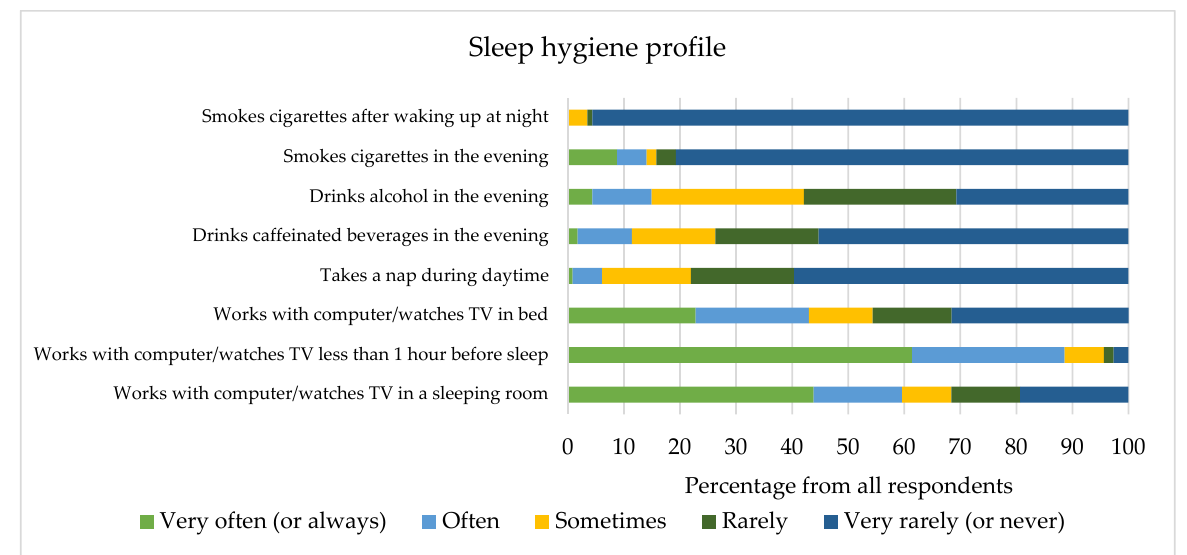
Figure 1. Questions evaluating the sleep hygiene of respondents in our study. The results of the SLOC questionnaire did not correlate significantly with aspects of respondents’ sleep hygiene habits ( p > 0.05). A lower SLOC score was associated with worse sleep efficiency (a subscale of the PSQI) (r s = − 0.280, p = 0.003), but not with general sleep quality, as measured by the total PSQI score (r s = − 0.098, p = 0.301). Seven (6.1%) respondents were confirmed to have COVID-19. None of them were hospitalized; however, four (57.1%) experienced long-term symptoms of COVID-19. Their sleep quality and anxiety levels were comparable to those who remained non-infected (Z = 0.989, p = 0.369; Z = − 0.456, p = 0.648, respectively). There were 12 (10.5%) individuals who had to self-isolate during the previous month. The median number of days when respondents worked remotely during the previous month was 12 (0–31). Answers to ques- tions related to daily life changes due to the COVID-19 pandemic are presented in Figure 2. A reported increase in appetite and a decrease in physical activity and sleep duration dur- ing the COVID-19 pandemic were associated with higher PSQI scores (r s = 0.242, p = 0.009, r s = − 0.284, p = 0.002, and r s = − 0.208, p = 0.026, respectively). COVID-19-related variables were not associated with measures of work productivity, apart from a relationship between a self-perceived decrease in productivity during the pandemic and measures of absenteeism (4-week absolute absenteeism: r s = − 0.290, p = 0.002; 4-week relative absenteeism: r s = − 0.298, p = 0.001).